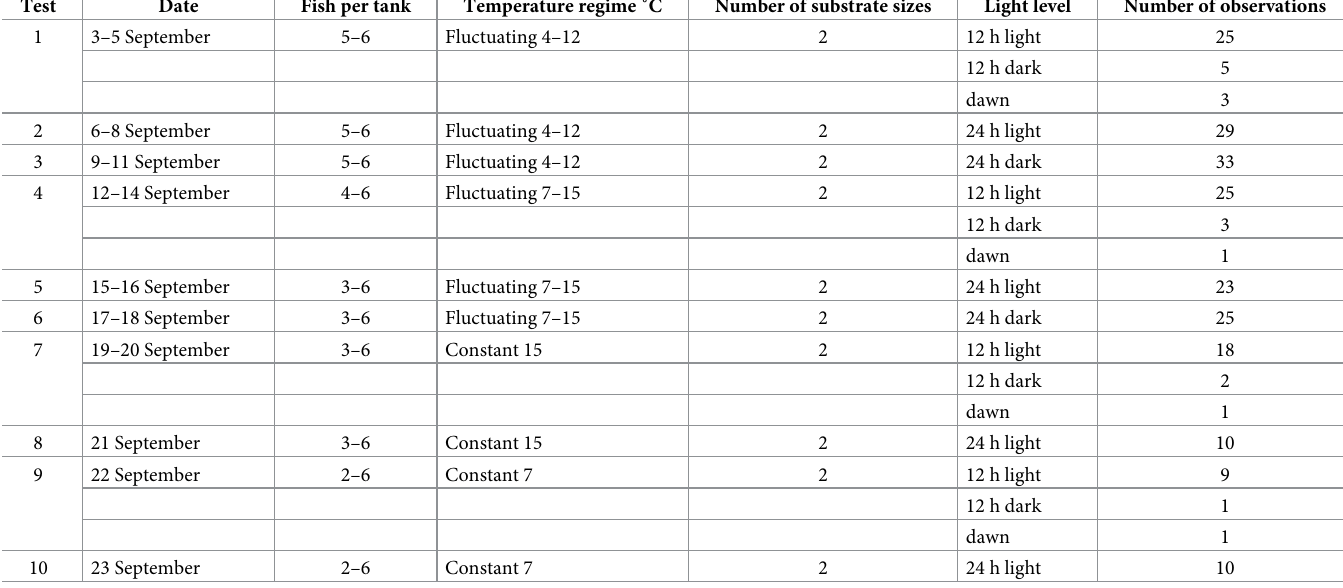
Table 1. Experimental design of wild bull trout aquarium trials. Each trial used 16